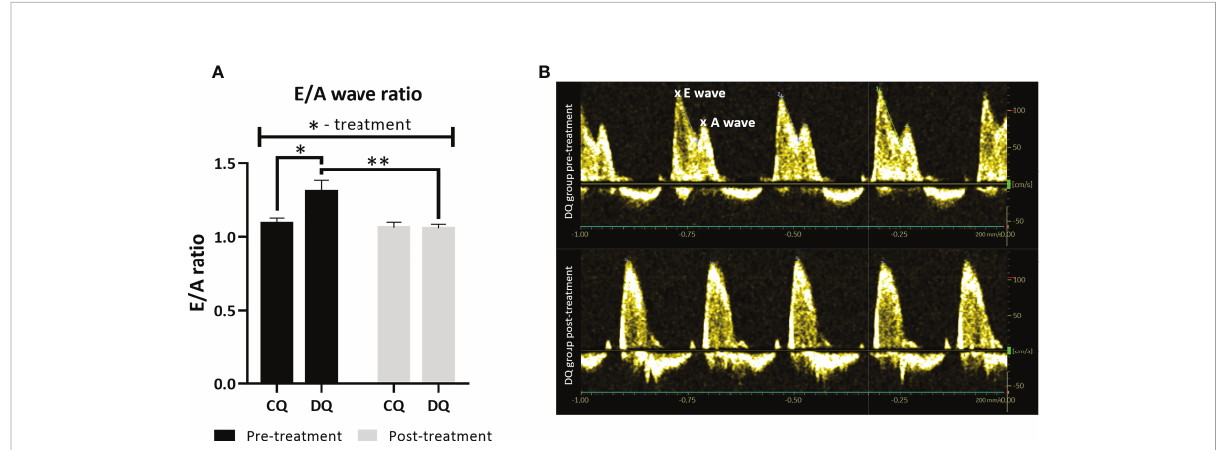
FIGURE 1 The assessment of LV diastolic function at two different time points – pre-treatment (week 0 – prior to the administration of Que) and post- treatment (week 6 – at the end of the Que treatment course). (A) E/A ratio of transmitral in fl ow from early (E wave) to late (A wave) diastole. (B) Representative echocardiographic image of E/A ratio in DQ group pre-treatment vs. post-treatment. Data are presented as mean ± SEM and statistical differences as * p < 0.05, **p < 0.01 (two-way ANOVA paired with Holm-Sidak´s multiple comparisons